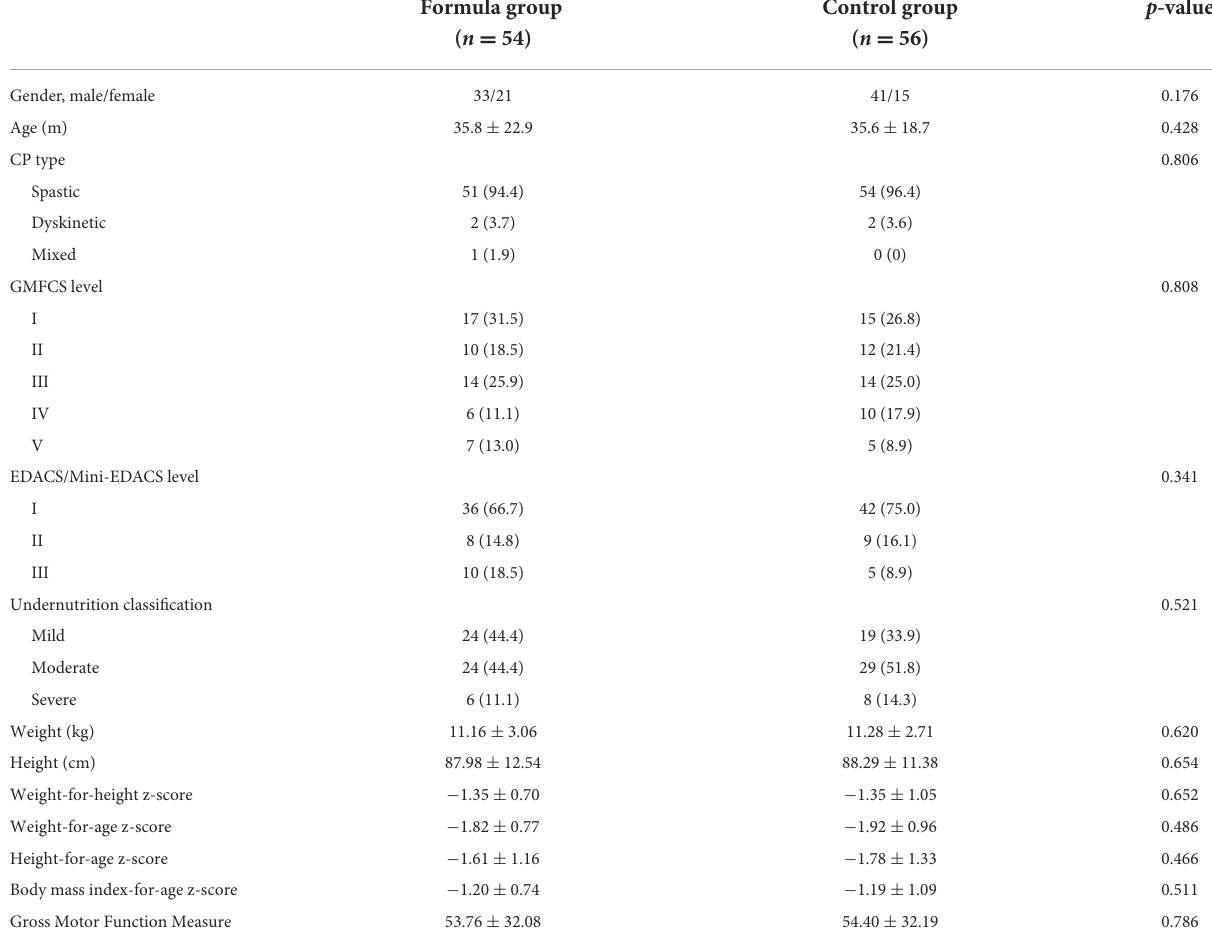
TABLE 1 Demographic and clinical